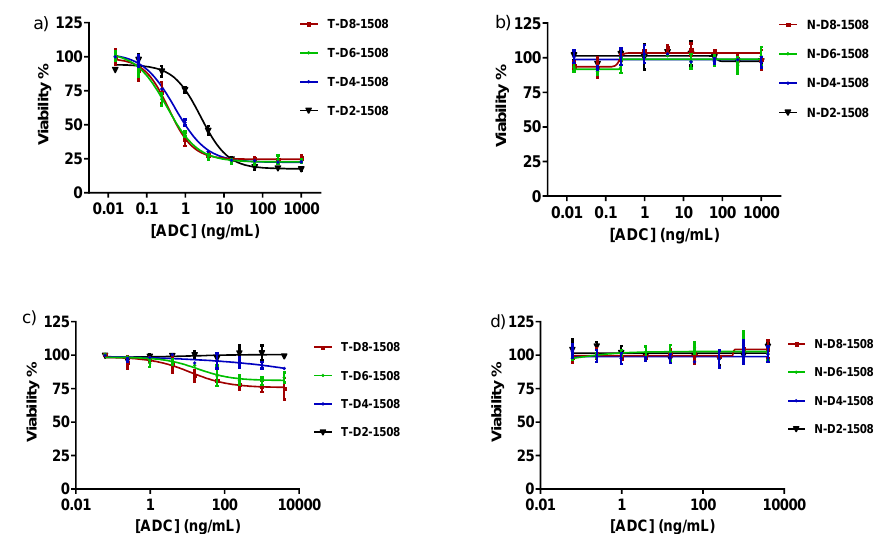
Figure 5. In vitro cytotoxicity assay performed on ( a ) HER2 2 + -expressing MDA-MB-361 cell line using site-specifically derived trastuzumab conjugates carrying AZ-1508 ( b ) MDA-MB-361 cell line using site-specifically derived NIP228 conjugates carrying AZ-1508 ( c ) Her2 1 + T47D Cell breast cancer cell line using site-specifically derived trastuzumab conjugates carrying AZ-1508 as the payload ( d ) Her2 1+ T47D Cell breast cancer cell line using site-specifically derived NIP228 conjugates carrying AZ-1508